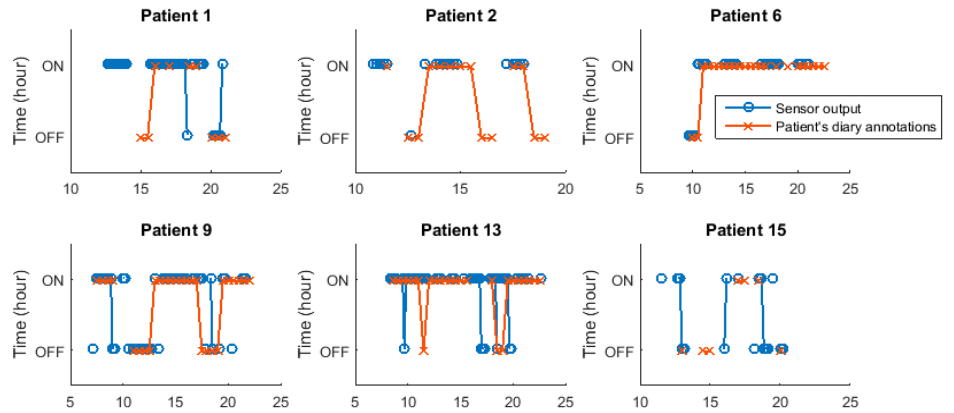
Figure 8. ON/OFF patterns for patients 1, 2, 6, 9, 13 and 15. Patterns obtained from the self-reported diaries and provided by the sensor are